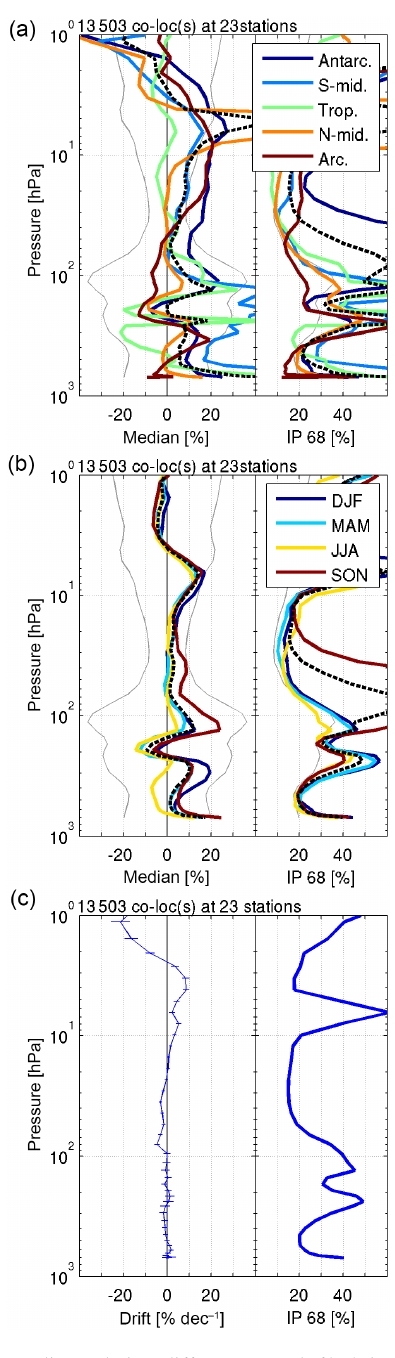
Figure 13. Median relative differences and 68% interpercentile spreads for comparison of L4 assimilated nadir ozone profile data with ground-based reference measurements (a, b) . The same differ- ence statistics are redistributed over two influence quantity ranges, with the influence quantities being the latitude (a) and quarter (b) . The black dashed line shows the average of the coloured curves, while light grey lines indicate the satellite uncertainty provided in the product. Panel (c) shows the corresponding relative decadal drift and 68% interpercentile spread. Two sigma error bars, resulting from a bootstrapping with 1000 samples, are added to the drift pro-